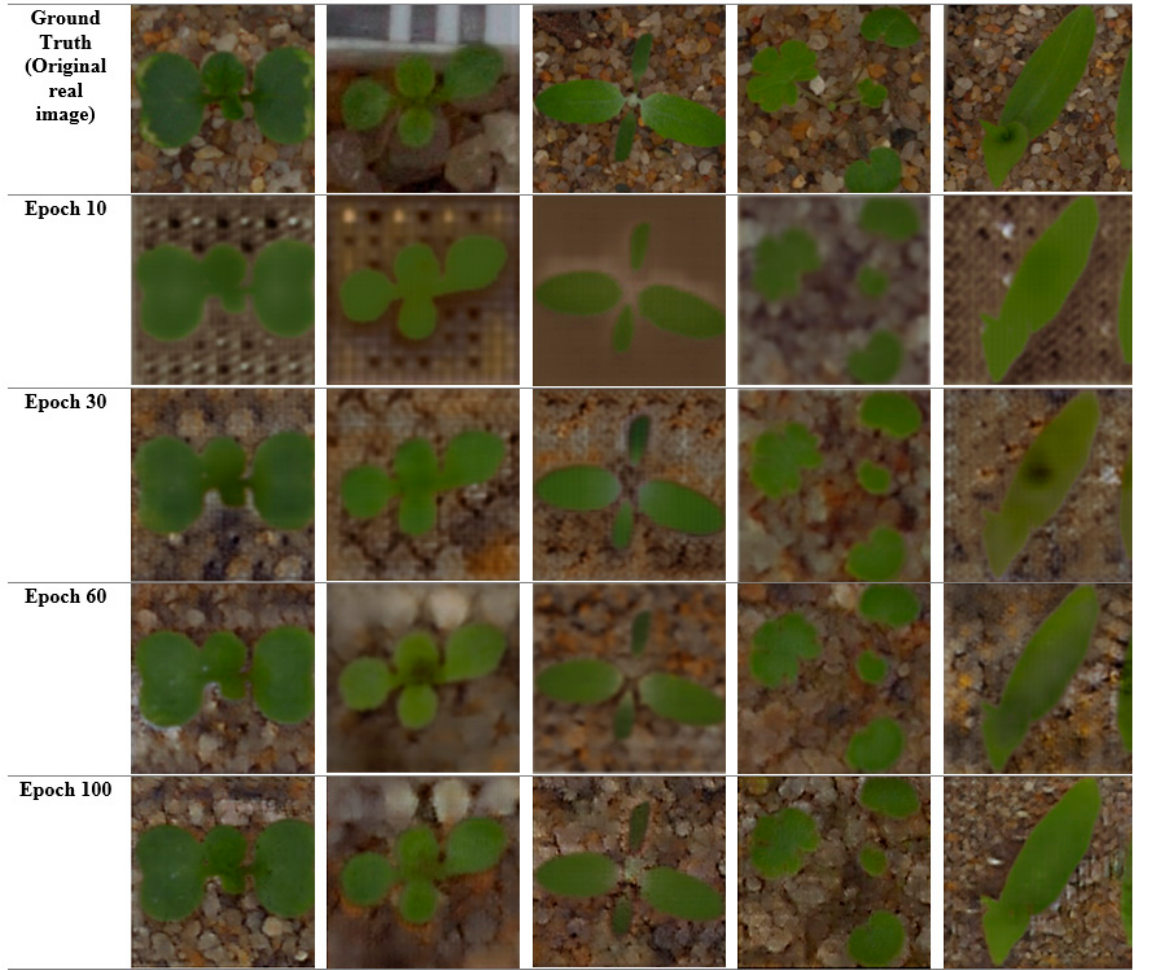
Figure 6. Sample ground truth images and generated images at different epochs during GAN training. Column-wise from left to right: Charlock, Fat Hen, Shepherd’s purse, Small-flowered Cranesbill, Maize.